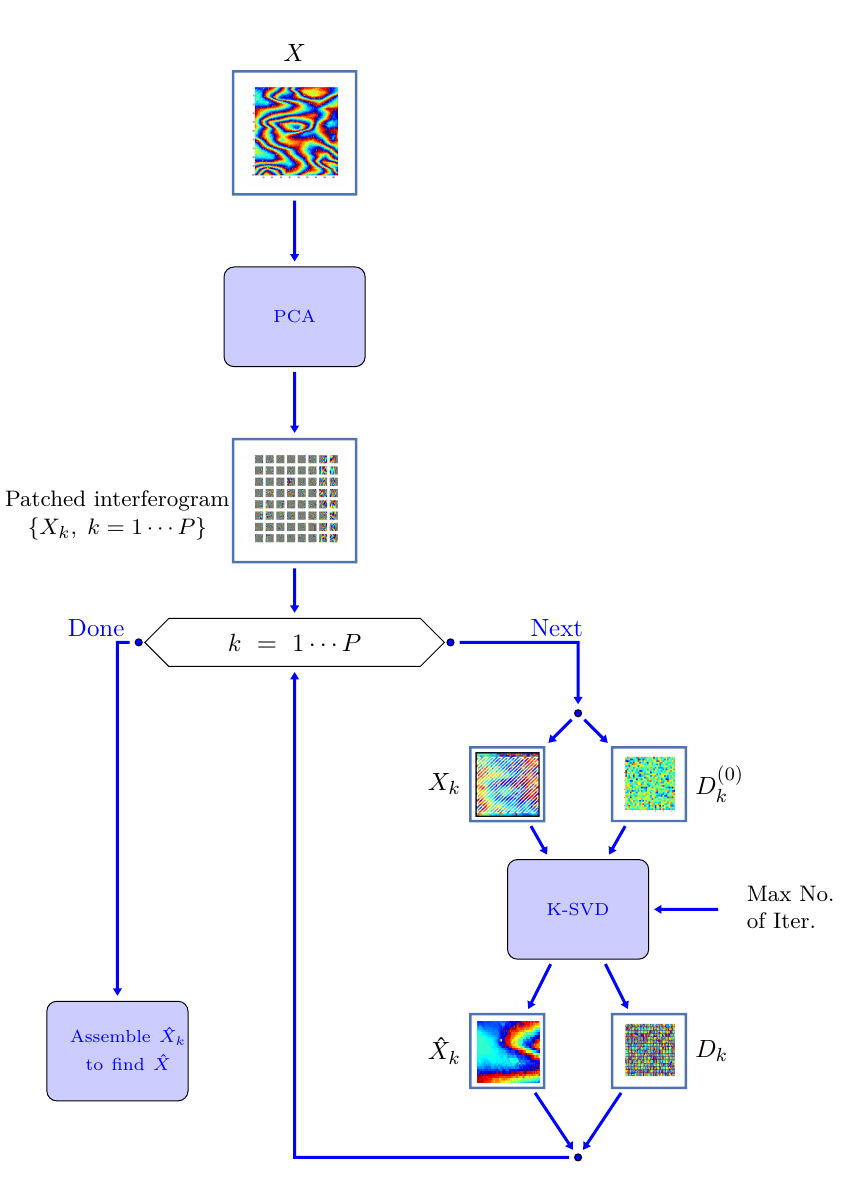
Figure 5. Block diagram of ProK-SVD Synthetic Aperture Radar (SAR) interferogram denoising algorithm. In the first step an unsupervised PCA analysis is implemented aimed at decomposing the original image into P patches of size n n . In the second step each patch X k is re-arranged into a 1 D array using proximity, an initial dictionary D ( 0 ) is chosen, and the K-SVD algorithm is run (up to a suitable maximum number of iteration) to obtain a denoised version of the patch ˆ X k , and the related (optimal) dictionary D k . Finally, all denoised patches are re-assembled to form the denoised (full) interferogram ˆ X